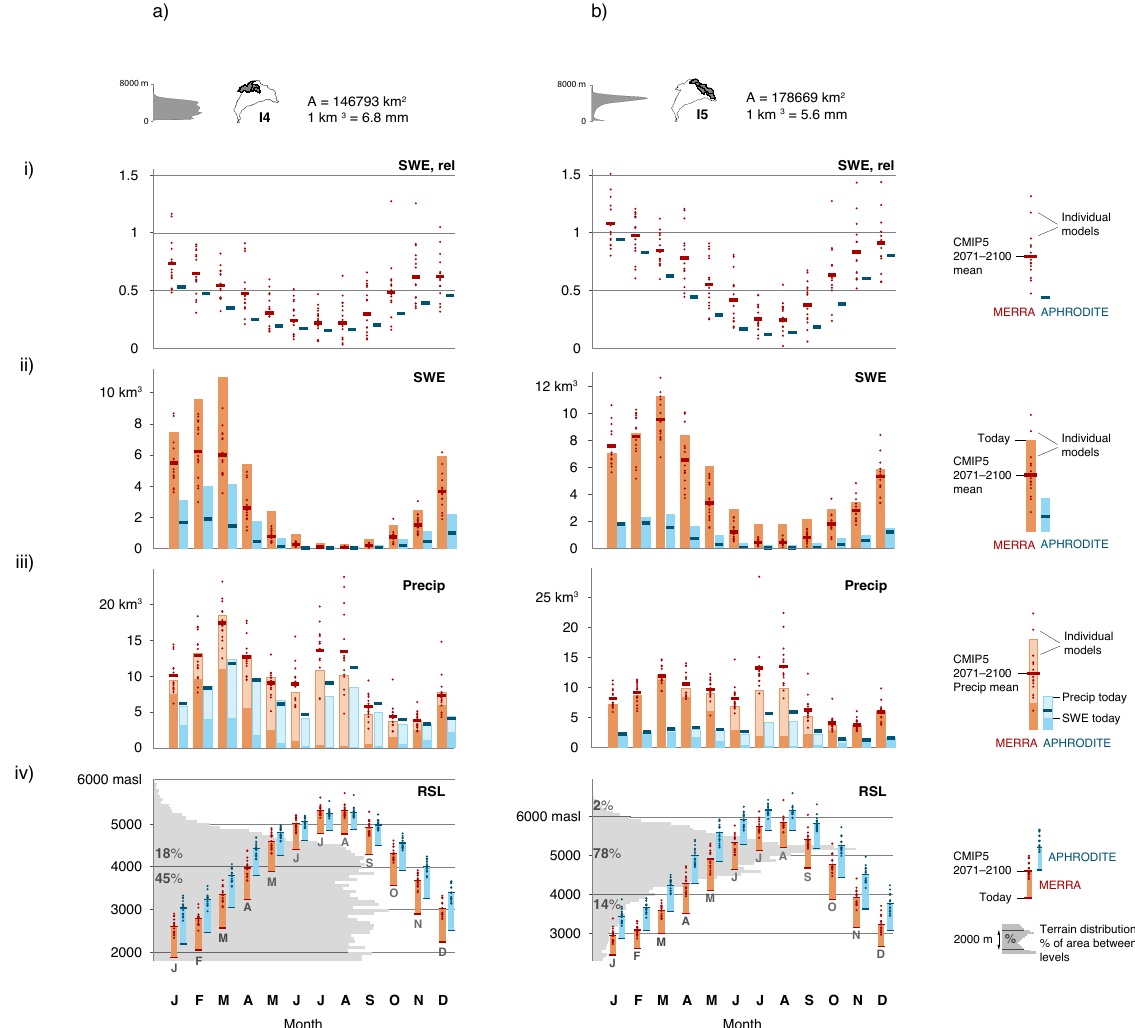
Figure 12. Monthly CMIP5 RCP8.5 change in snowfall, precipitation and rain/snow line elevation in the upper Indus clusters 4 (a) and 5 (b) , from 1971–2000 to 2071–2100, with reference to the MERRA reference (red) and APHRODITE (blue). CMIP5 multi-model means are shown as horizontal marks, individual models as dots. Cluster location and terrain profile are shown above the graphs. (i) Fractional change in snowfall. (ii) Future snowfall (km 3 ) (dots) compared to today (bars). (iii) Future precipitation (km 3 ) (dots), compared to today (bars). Snowfall today is shown as darker parts of bars. (iv) Rain/snow line elevation (ma.s.l.). Gray background indicates elevation histogram with the % of total ground area lying in the marked 2000m intervals. Bars: change from today (bottom panels) to CMIP5 multi-model mean (top